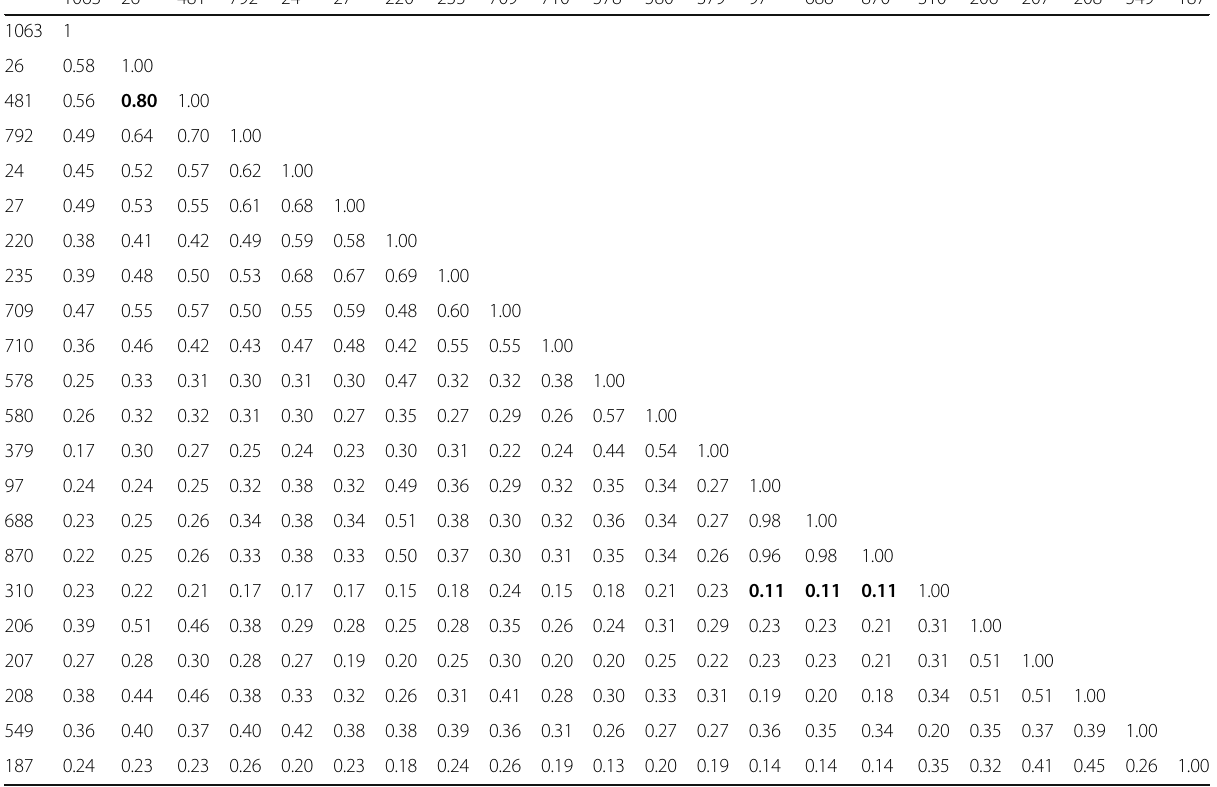
Table 3 Binary matrix and similarity indices among pumpkin